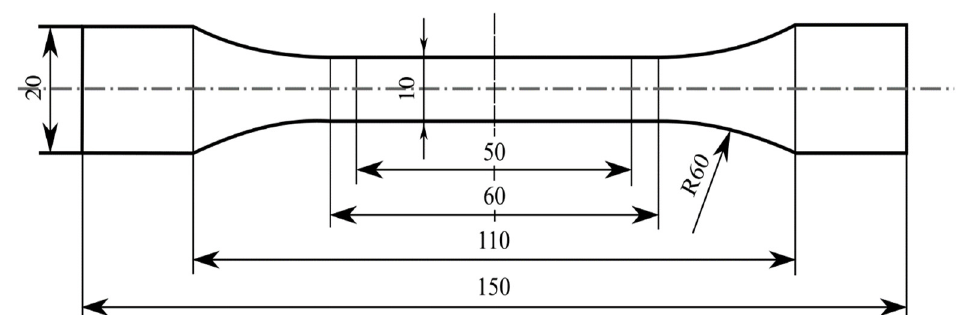
Figure 14. The dimensions of the dumbbell-shaped specimens [48].